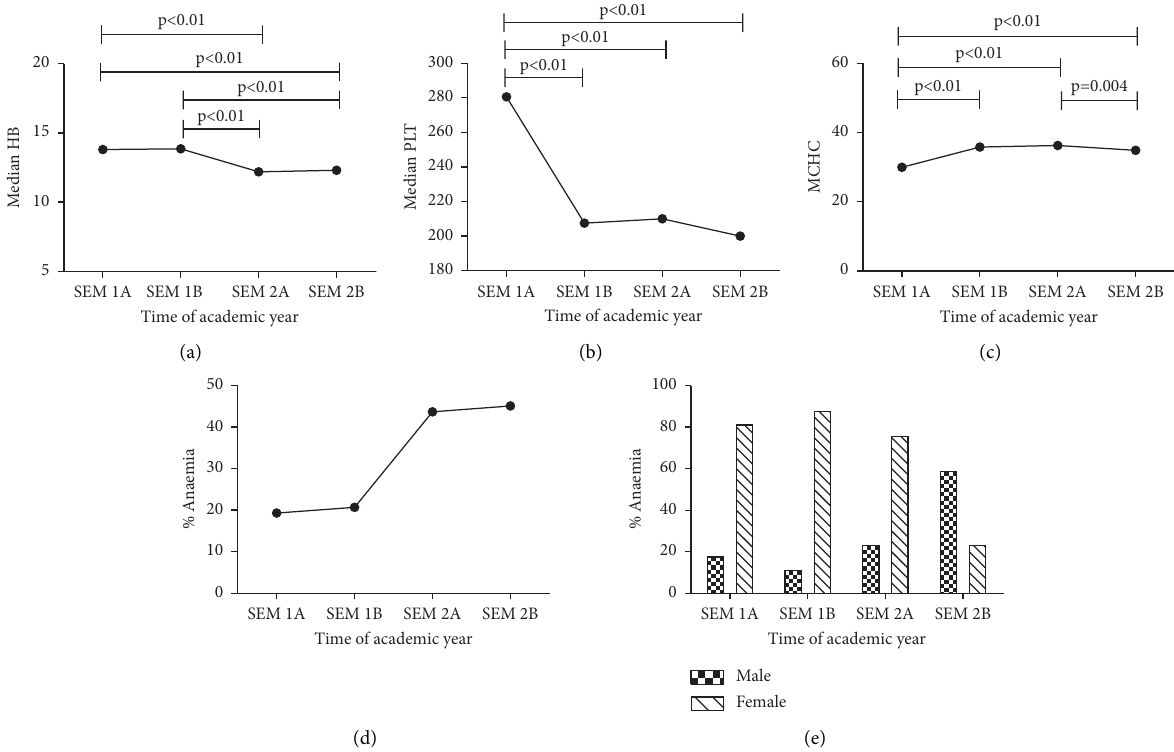
Figure 1: The trend of the measured parameters during one academic year. (a) The trend of haemoglobin concentration. (b) The trend of the change in platelet count. (c) The pattern of the change in MCHC of participants. (d) The prevalence of anaemia among the participants of the study at each time point. (e) The gender-wise distribution of anaemia prevalence (Semester 1A, early part of first semester; Semester 1B, latter part of first semester; Semester 2A, early part of second semester; Semester 2B, latter part of second semester (Kruskal–Wallis with Dunn’s multiple comparison test was performed)). HB: haemoglobin, MCHC: mean cell haemoglobin concentration; PLT: platelet, and BMI: body mass